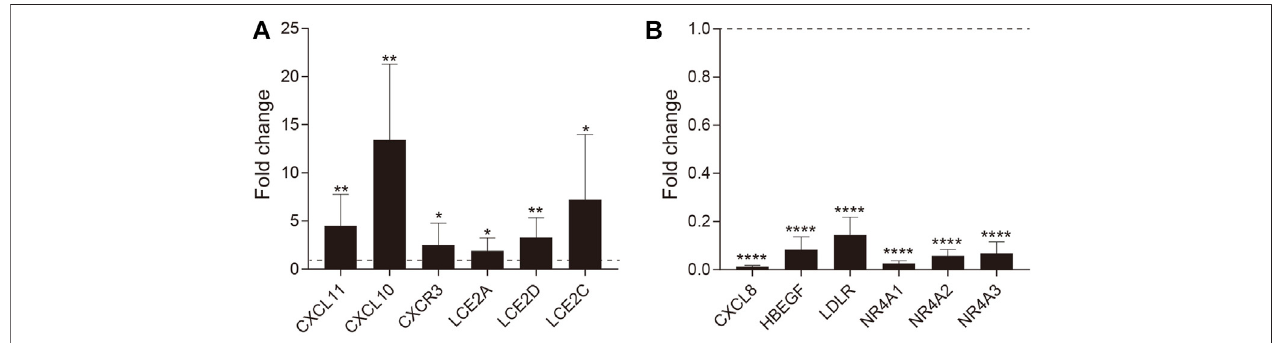
FIGURE 5 | RT-qPCR validation of DEGs. The fold-change in expression is shown for (A) upregulated and (B) downregulated genes. Error bars represent the standard error of the mean (* p value ≤ 0.05, ** p value ≤ 0.01, **** p value ≤